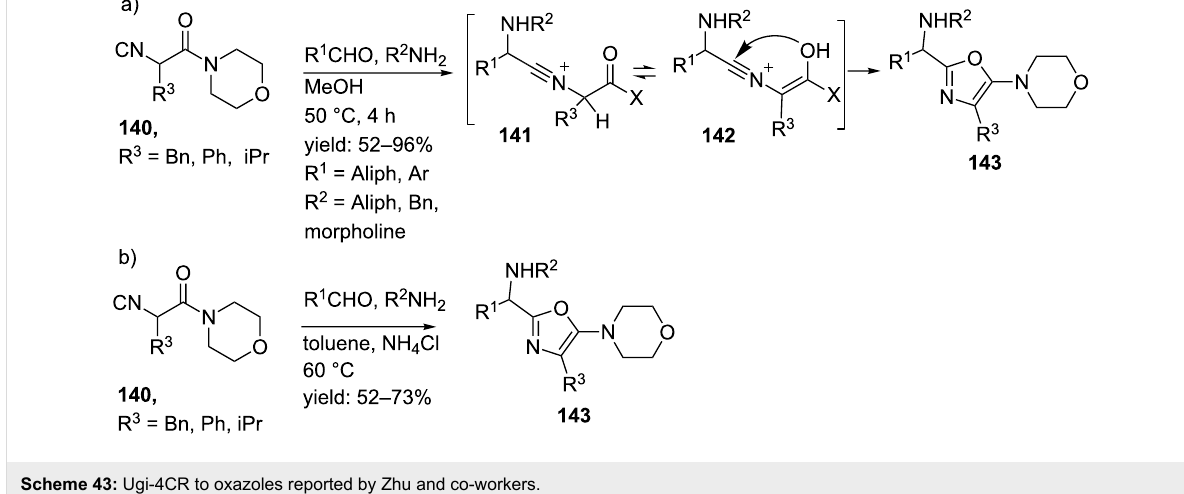
Scheme 43: Ugi-4CR to oxazoles reported by Zhu and co-workers.